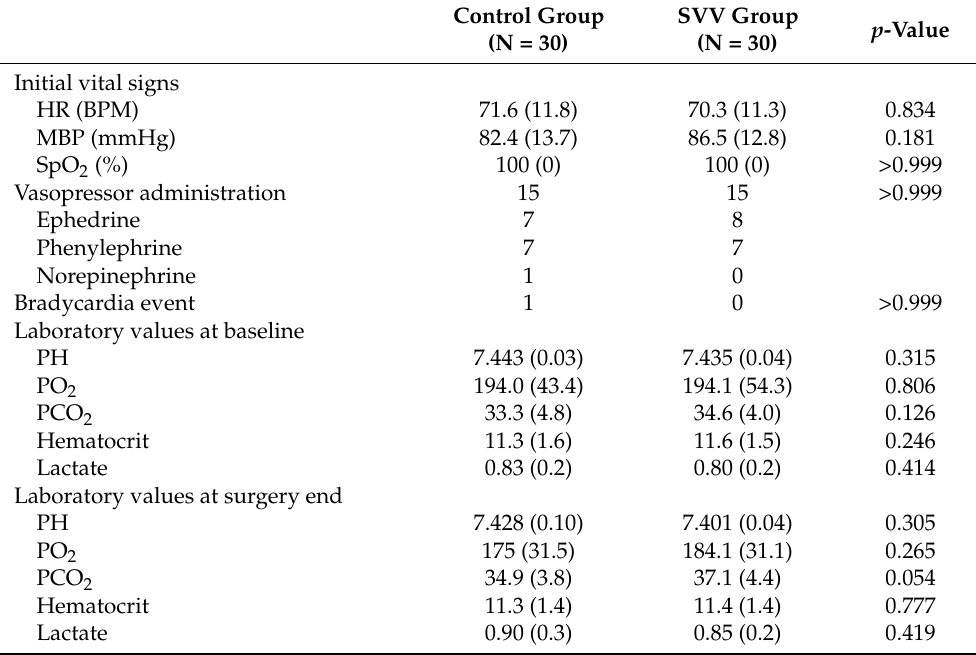
Table 2. Intraoperative